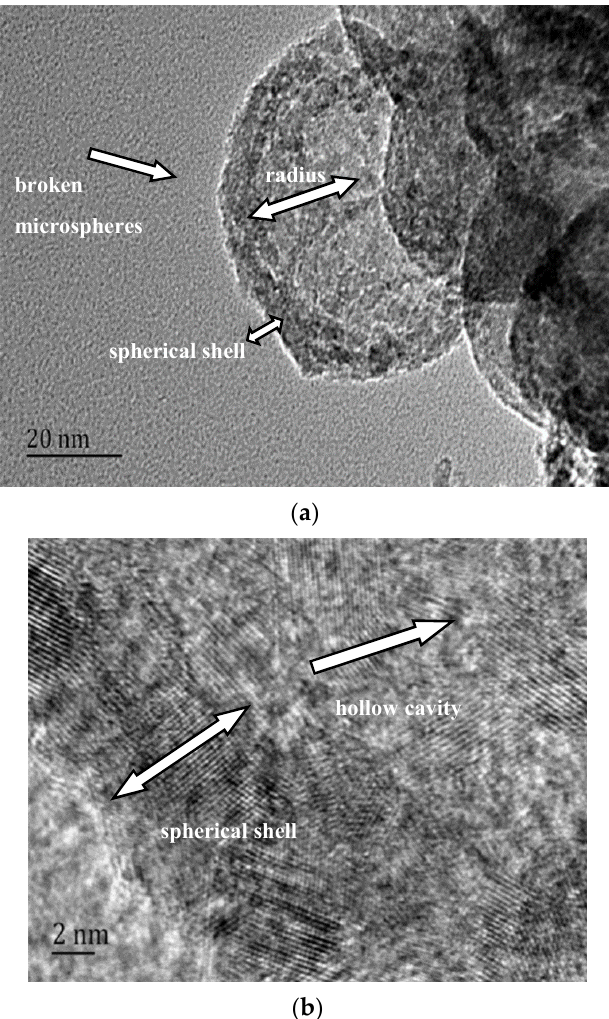
Figure 6. TEM images of the sample. ( a ): TEM images of cracked magnesia hollow sphere; ( b ): TEM images of the surface of cracked magnesia hollow